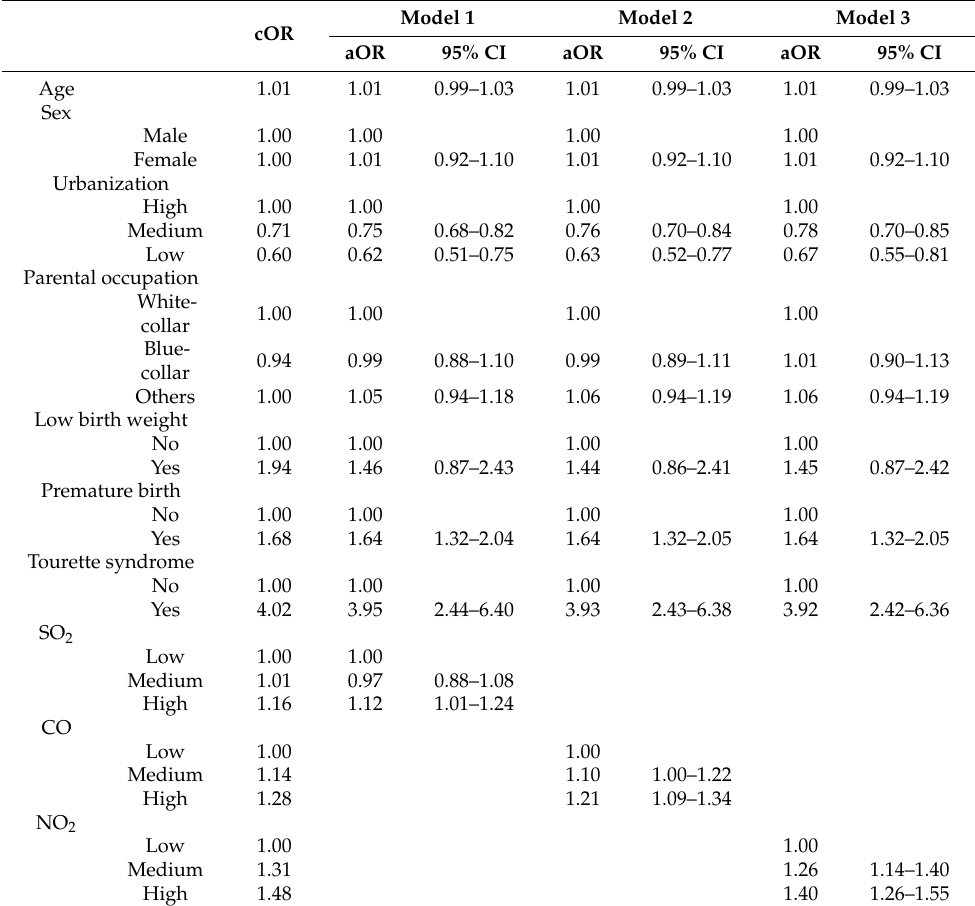
Table 3. Adjusted odds ratios for development delays and associated air exposure.